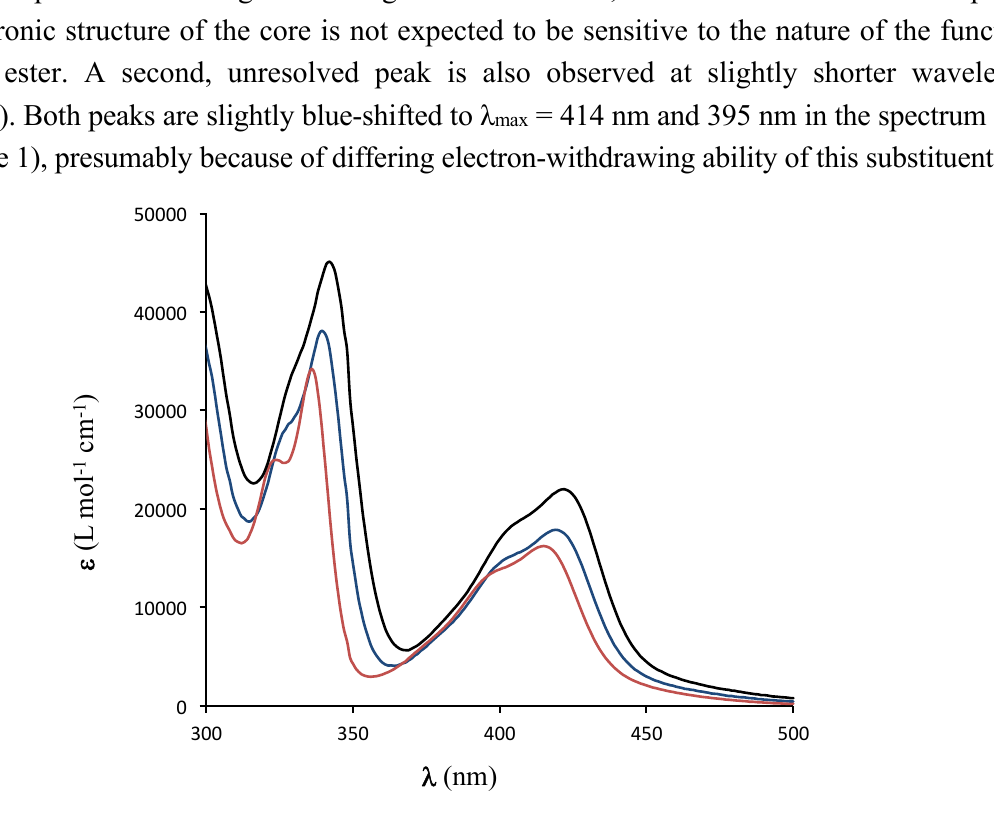
Figure 1. UV-visible absorption spectra of 2b (blue), 4 (black) and 7 (red) in CHCl 3